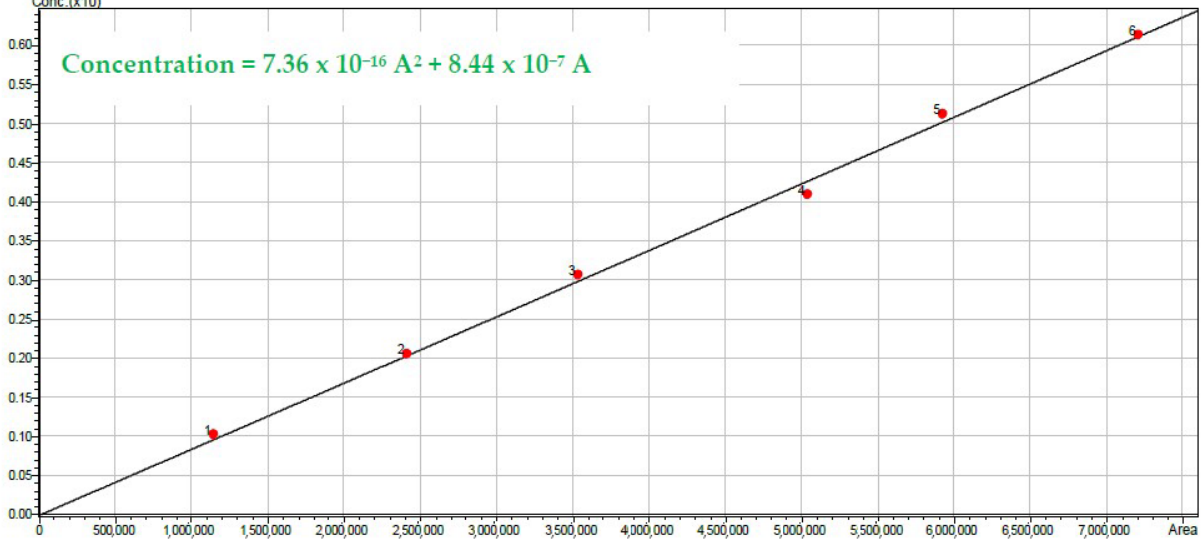
Figure A3. Calibration curve using the Shimadzu GC 2010 for